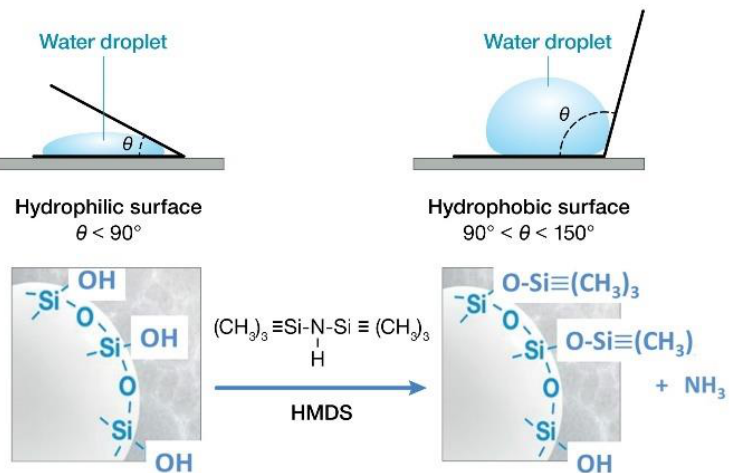
Figure 1. Appearance, elemental composition, and ATR-FTIR spectrum of HSA. Based on these ATR-FTIR findings, a hypothetical schematic image for hydrophobically treated silica aerogel with HMDS can be drawn (Figure 2).